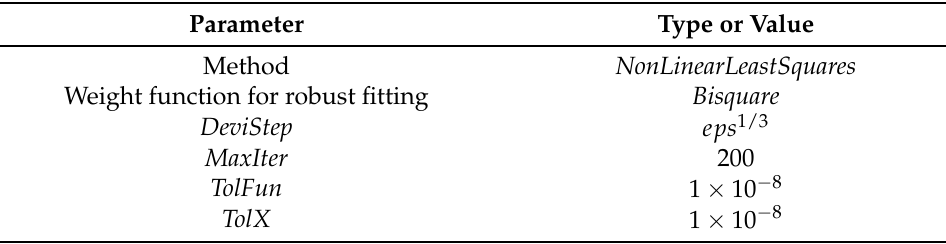
Table 4. Parameterization of multifitting algorithm.